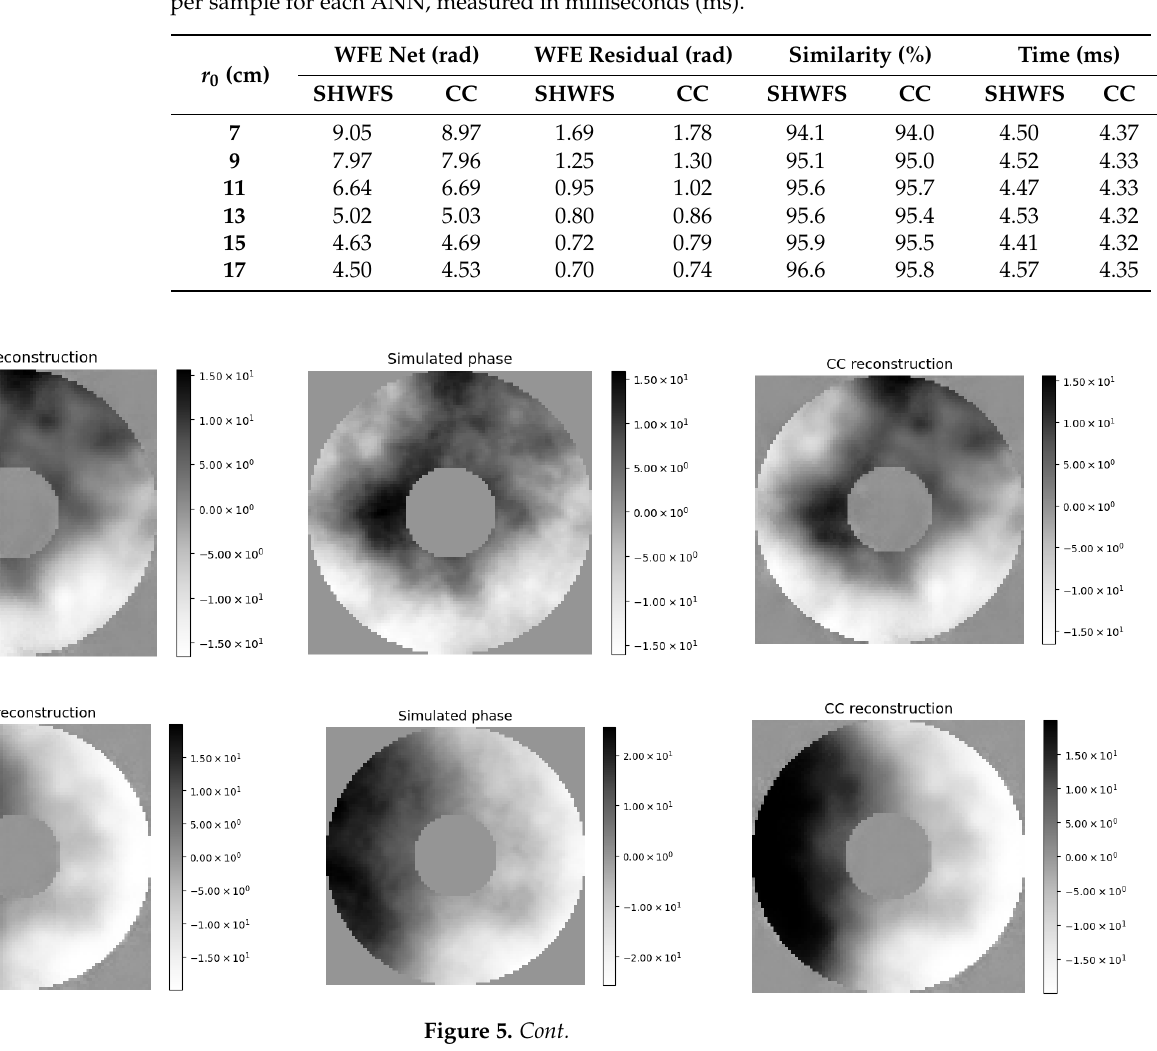
shown. The results are presented in the same way as in the previous subsection: first, Table 2 shows the analytical values of the errors, similarity, and time needed per reconstruction, and then Figure 5 allows for a visual comparison of a randomly selected example from each test dataset. Table 2. Results obtained for the high-altitude layer reconstructions. WFE net refers to the RMSE WFE calculated over the images given by each FCN as output, while WFE residual refers to the RMSE WFE of the image that is obtained as the difference between the output of one ANN and the original simulated image. Both terms are measured in radians (rad). SHWFS refers to the ANN that uses as input the information received by the subapertures of the sensor, while CC refers to the ANN that uses the cross-correlations (CC) as inputs. The time column shows the mean time over the dataset per sample for each ANN, measured in milliseconds (ms).